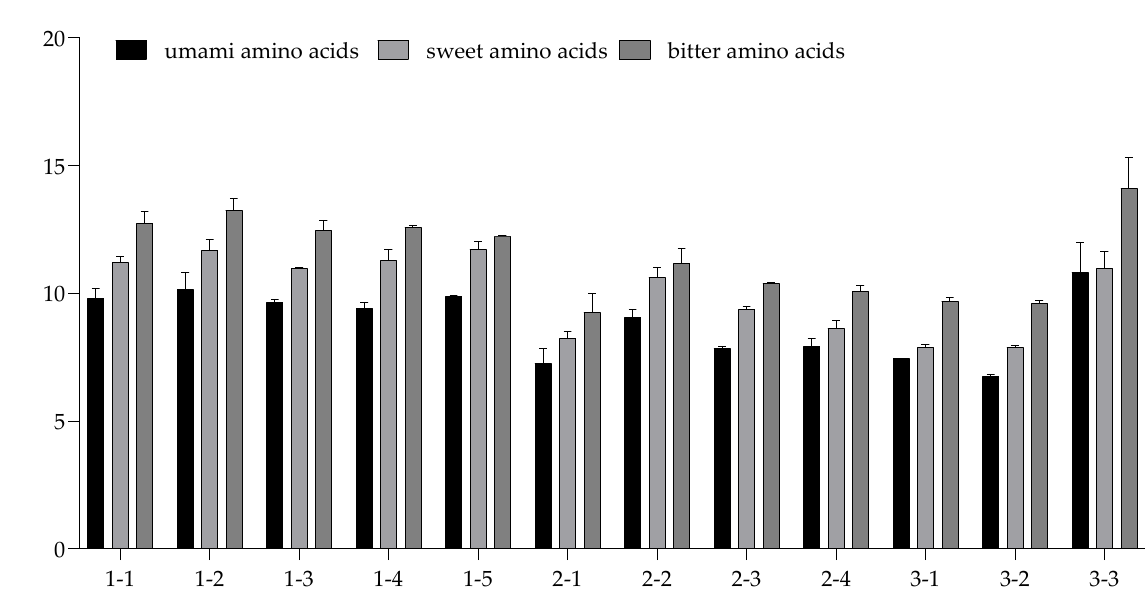
Figure 1. Contents of flavor amino acids in fresh corn of three regions. Glutamic acid (Glu) and aspartic acid (Asp) are umami amino acids; alanine (Ala), glycine (Gly), serine (Ser), proline (Pro), and threonine (Thr) are sweet amino acids; leucine (Leu), isoleucine (Ile), valine (Val), phenylalanine (Phe), methionine (Met), histidine (His), and arginine (Arg) are bitter amino acids.